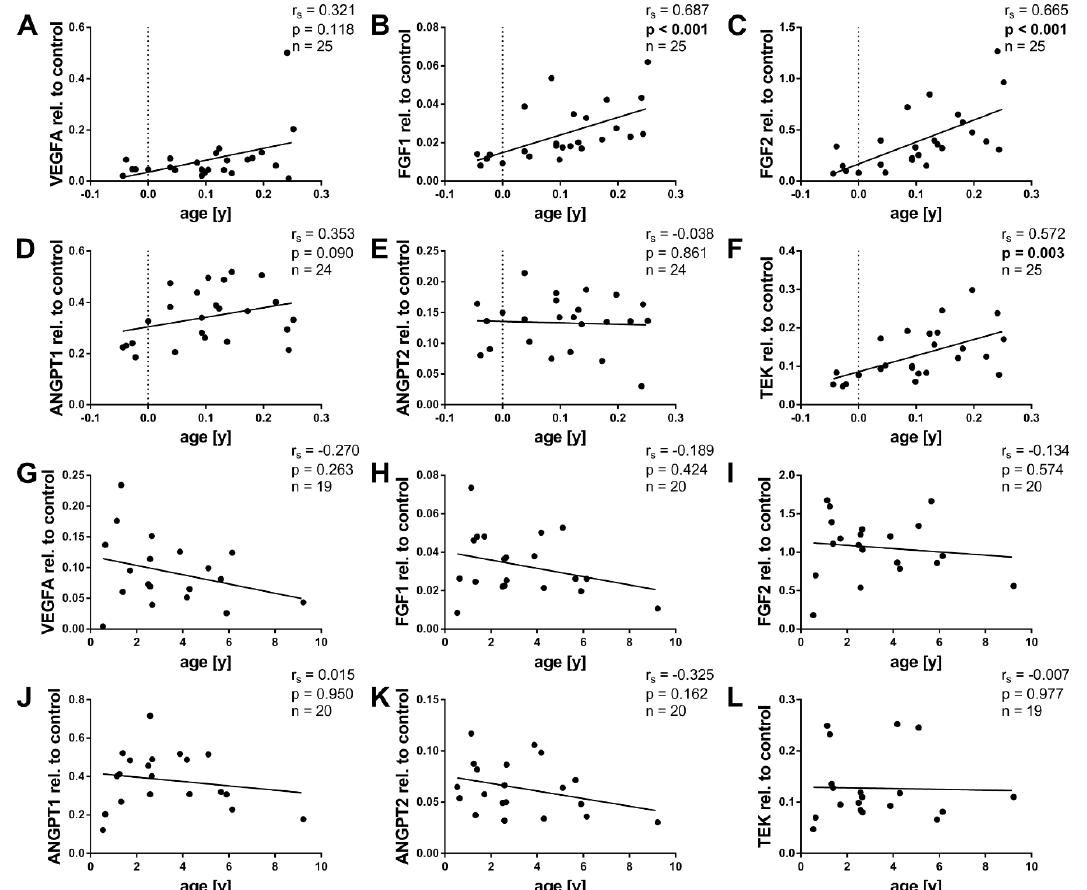
lines were calculated as linear regressions.